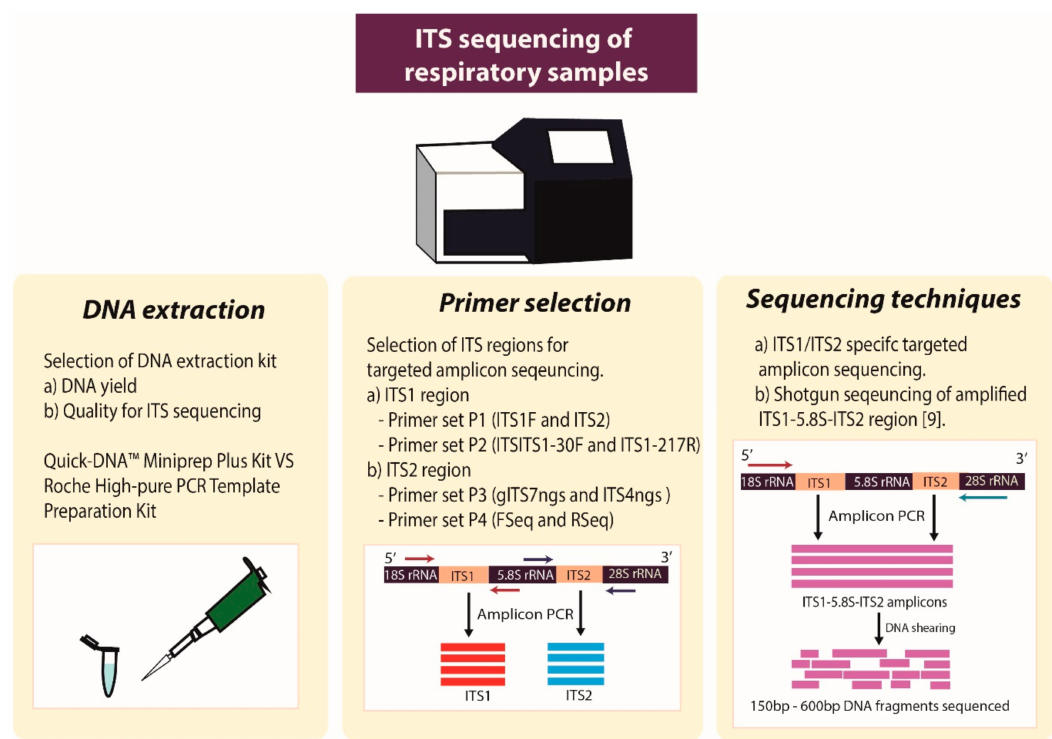
Figure 6. Schematic overview of important considerations for ITS sequencing of respiratory specimens, based on the findings of this study. DNA extraction methods may yield variable results in terms of yield and capacity to amplify the ITS region. Primer selection can influence the outcome significantly, both by determining the chances of successful ITS amplification and in terms of resultant ITS profiles derived. Our findings suggest the optimal pairing of the Roche extraction methods with ITS primer pair P4. Finally, the choice of amplicon sequencing technique may also contribute to di ff erences in the final derived ITS mycobiome